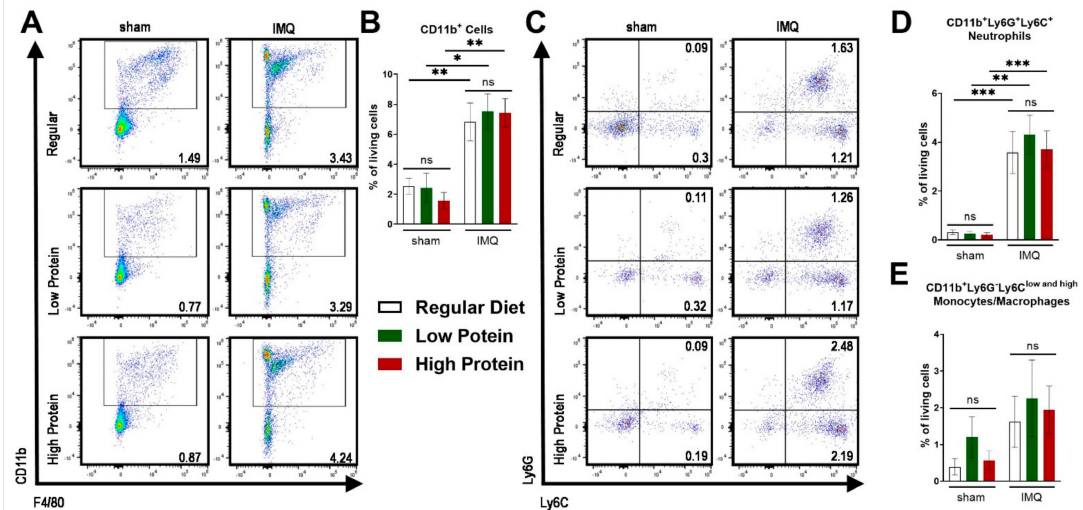
Figure 3. IMQ-treatment drives skin infiltration of myeloid cells independently of the dietary protein regime. Flow cytometric analysis of ear skin after sham or IMQ-treatment in mice on a regular, low, or high protein diet. ( A ) Representative flow cytometric plots gated on CD11b and F4/80 are shown for each group. ( B ) Quantification of CD11b + myeloid cells in the skin. To determine CD11b + myeloid cells, cells were pre-gated on living CD45.2 + cells ( n = 4–13; Kruskal–Wallis test). ( C ) Representative flow cytometric plots gated on Ly6G and Ly6C are shown for each group. Quantification of skin ( D ) neutrophils (CD11b + Ly6G + Ly6C + ) and ( E ) monocytes/macrophages (CD11b + Ly6G − Ly6C low and high ) ( n = 4–13; Kruskal–Wallis test). Data are shown as mean ± SEM. *** p < 0.001; ** p < 0.01; * p <